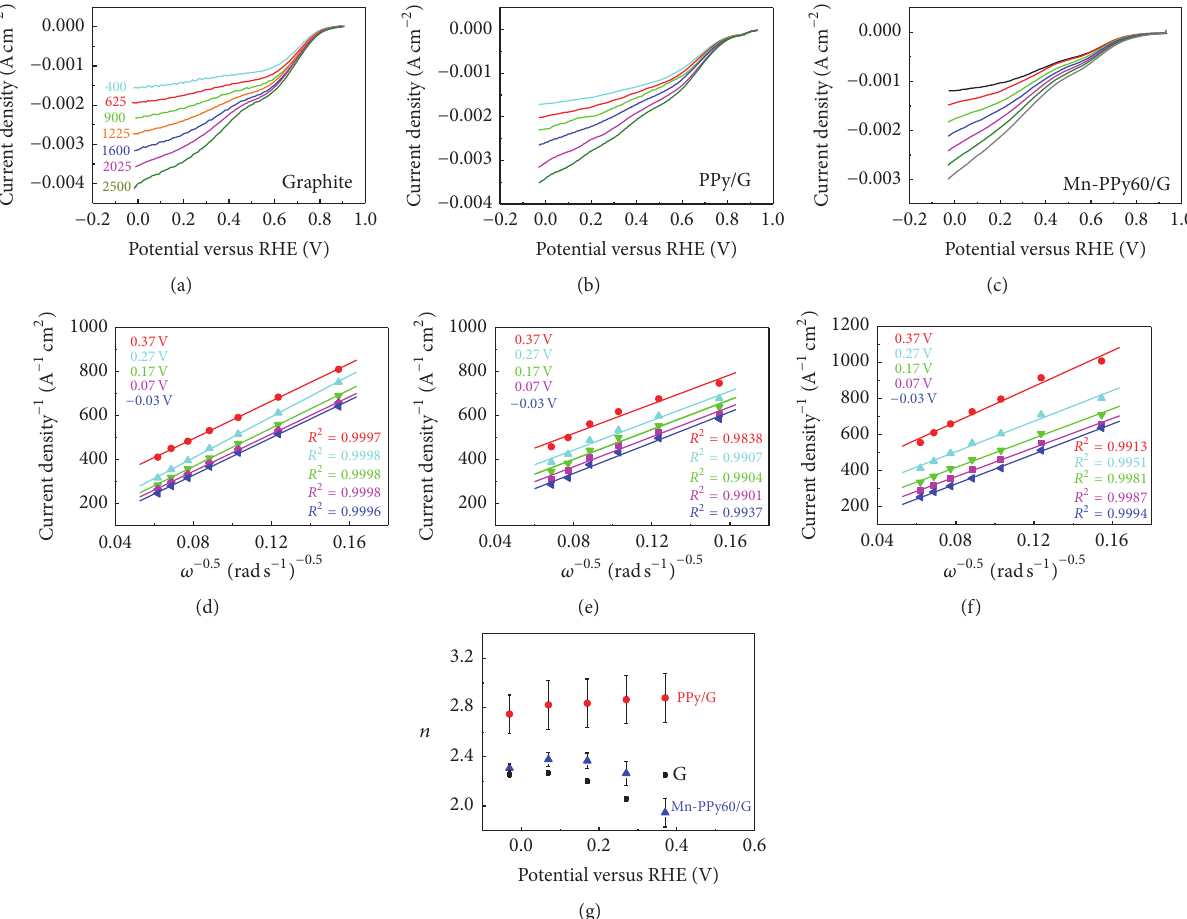
Figure 8: RDE voltammograms (scan rate: 5 mVs −1 ) in O 2 -saturated 0.1M KOH at different rotation speeds of (a) G, (b) PPy/G, and (c) Mn-PPy60/G electrodeposits. The N 2 background has been subtracted. (d–f) Koutecky–Levich plots derived from the curves of Panels (a, b, c) at a series of representative potentials. Symbols are experimental data; lines are the linear regressions. (g) Dependence of the electron transfer number 𝑛 on the electrode potential.